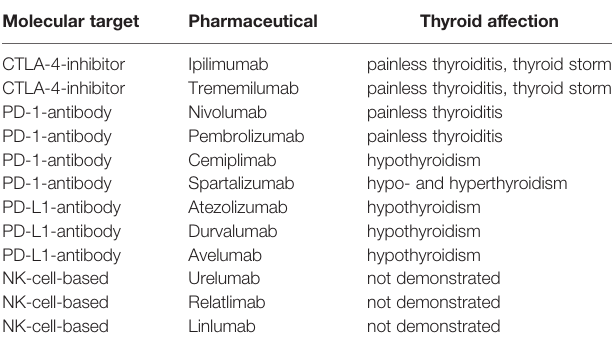
TABLE 1 | Immune related adverse effects of the thyroid caused by ICI therapy (4 –